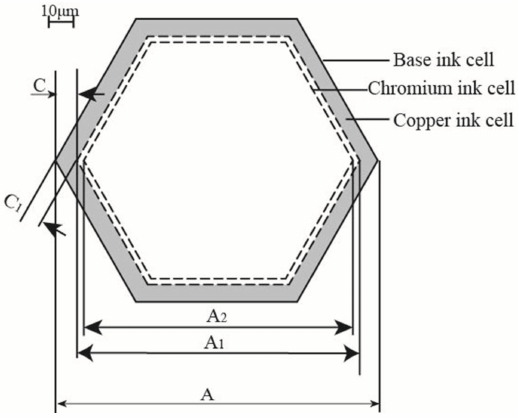
Figure 3. Regular hexagonal cell size.